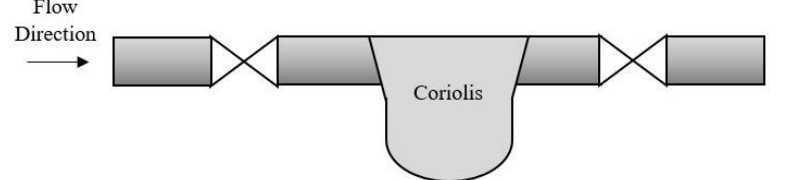
Figure 9. A coriolis meter placed inline of the pipe. Replacement of the meter will cause a shut down in the oil production in the given